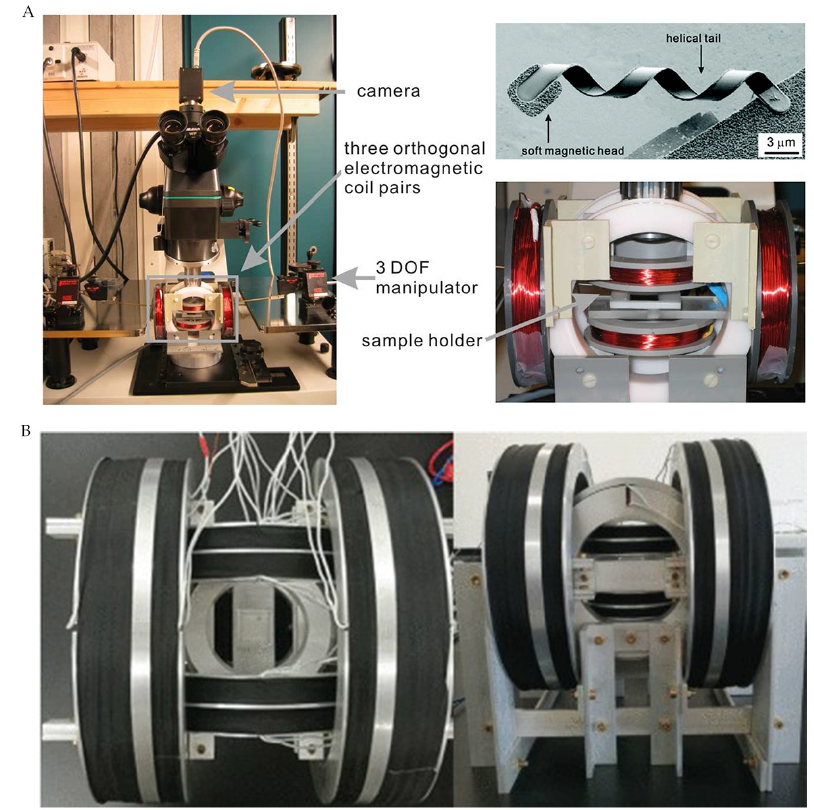
Figure 2. ( A ) Magnetic microswimmer and its electromagnetic actuation system. Adapted with permission from [15]. Copyright 2009 American Chemical Society. ( B ) EMA system. Reproduced with permission from ref [27]; published by IEEE,